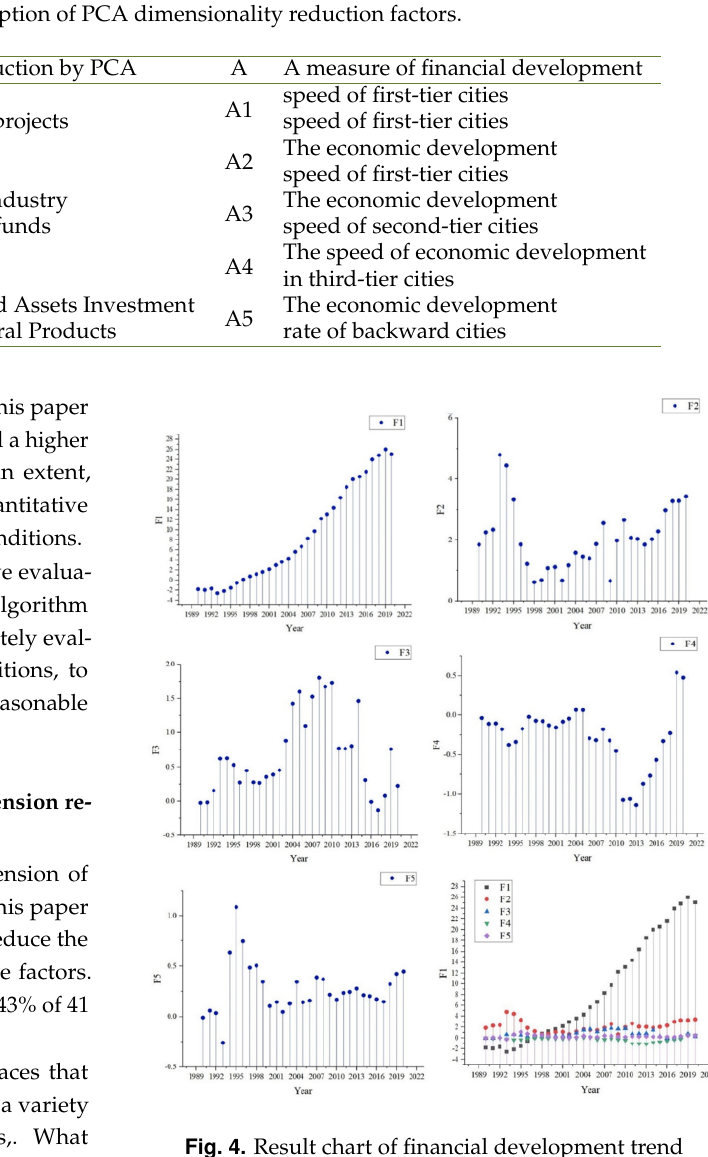
Fig. 4. Result chart of financial development trend calculated after PCA dimension